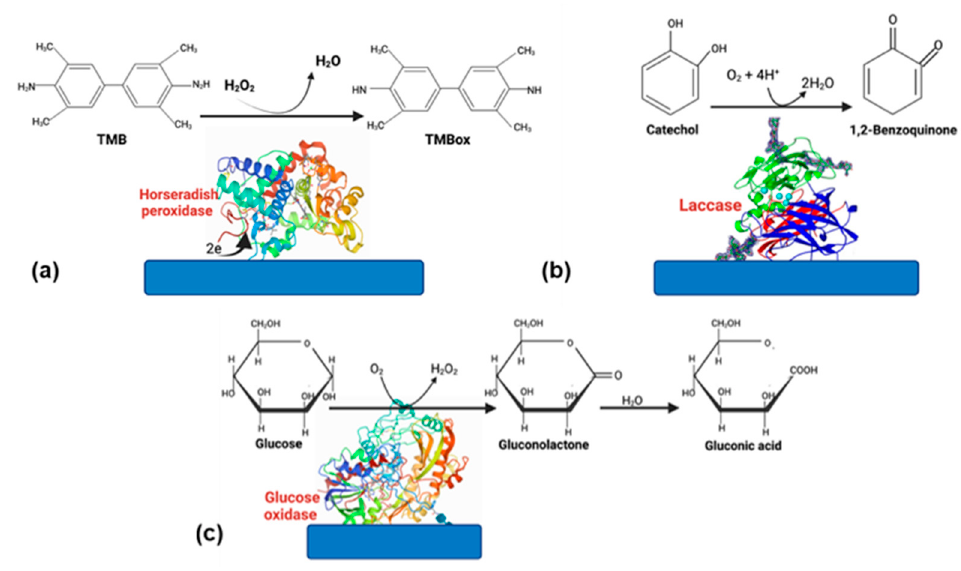
Figure 3. Enzymes commonly used in biosensors. ( a ) HRP, ( b ) laccase, and ( c ) glucose oxidase.